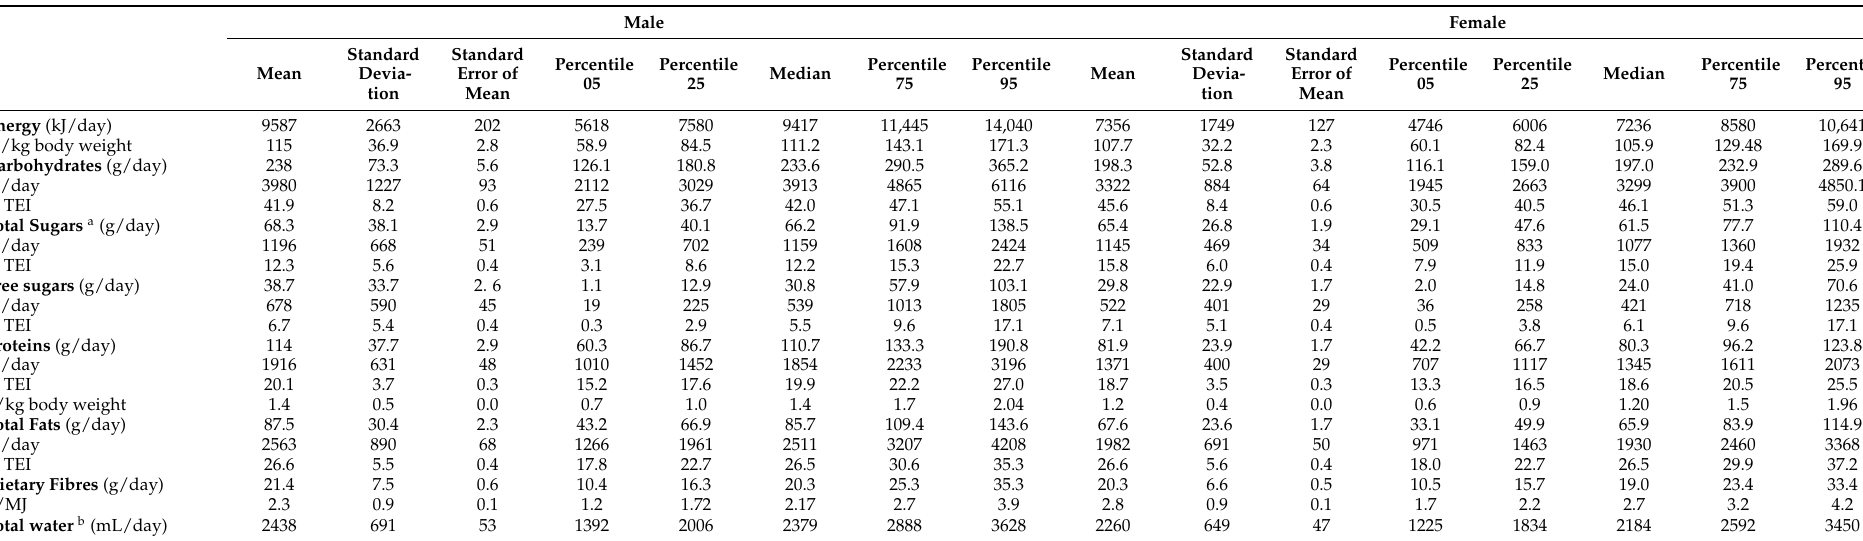
Table 4. Descriptive statistics of usual daily intakes of energy, macronutrients, dietary fibre, and water among male and female adults (18–64 years).